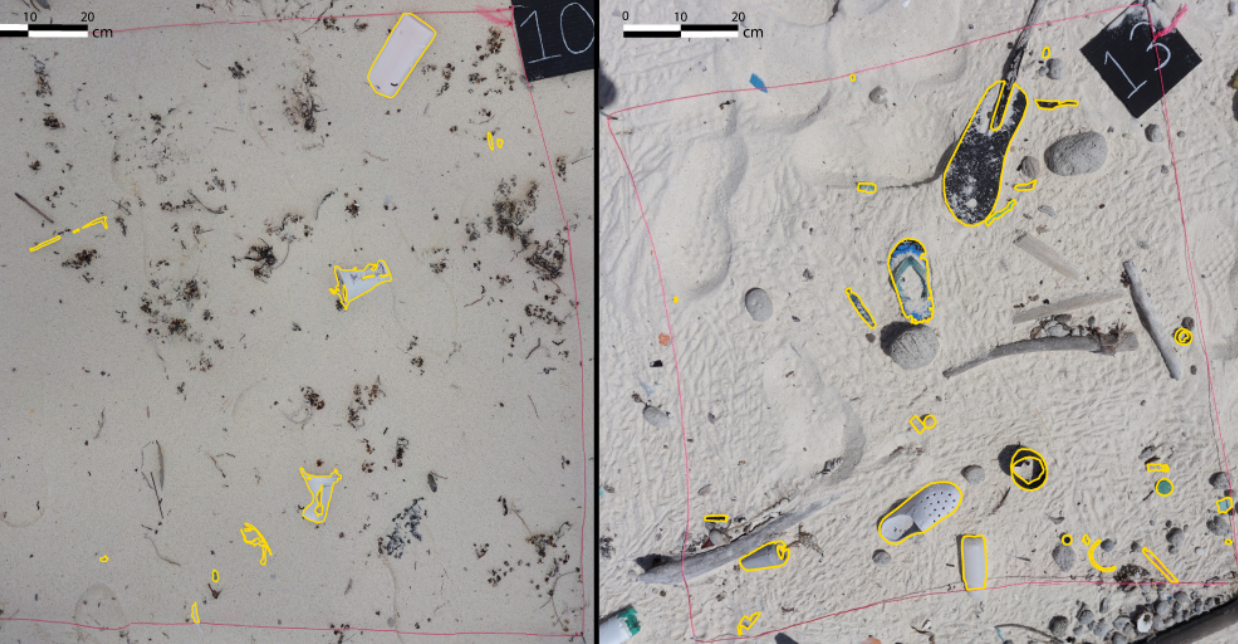
Figure 3. Plastic items within quadrats were digitised to determine the apparent surface coverage of plastic debris (yellow